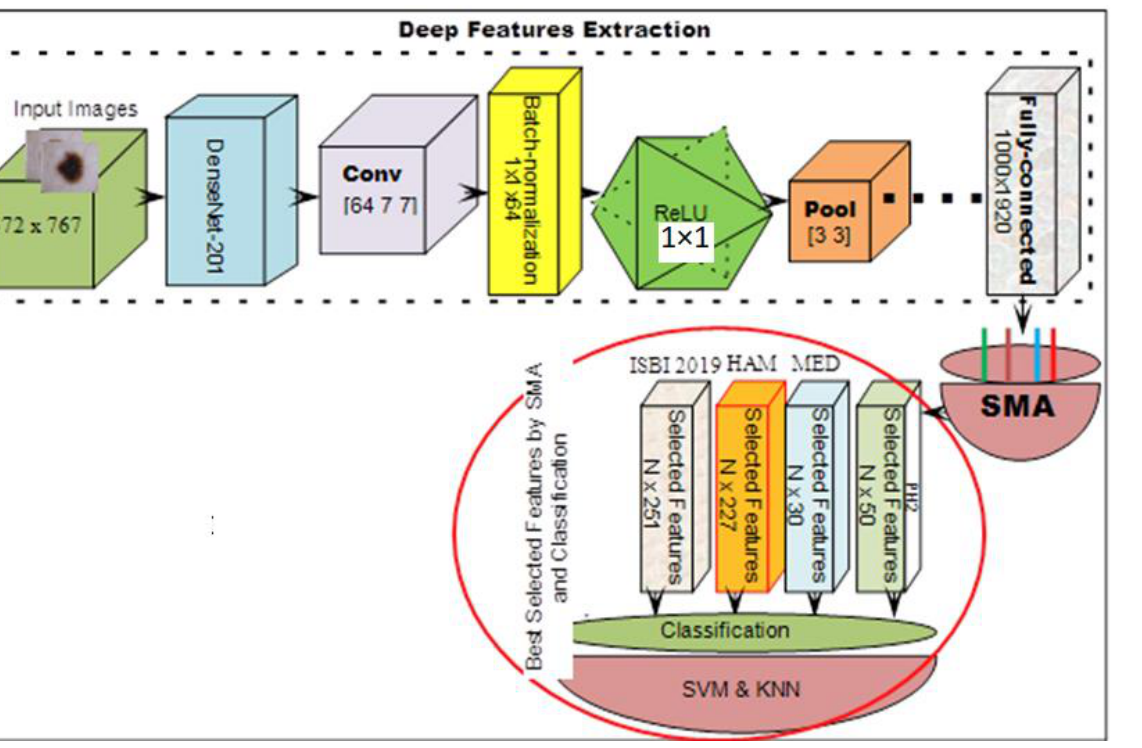
Figure 5. Optimal features selection using SMA.